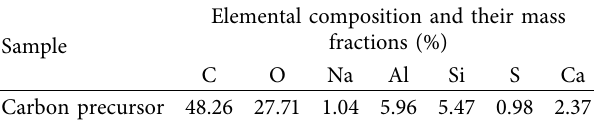
Table 5: Optimization of activation condition orthogonal analysis results.